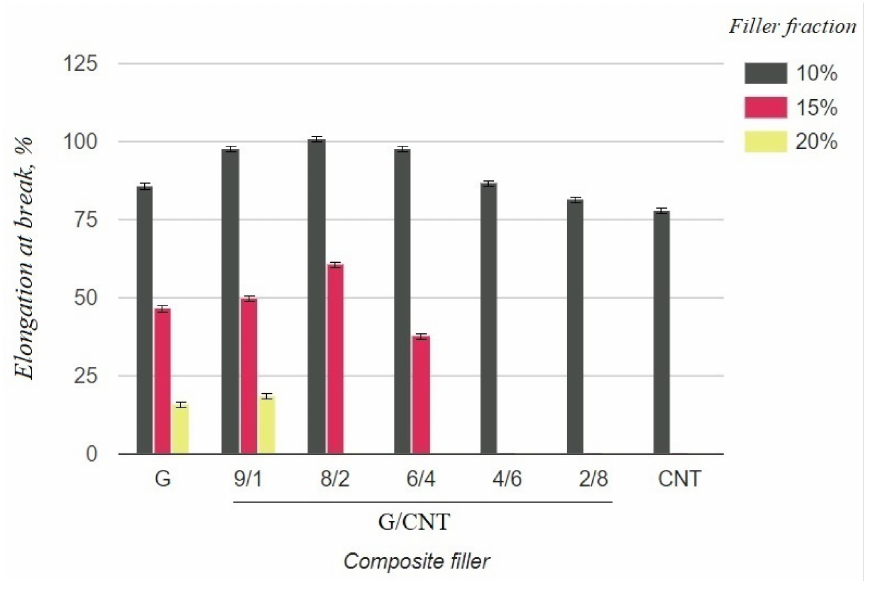
Figure 4. Elongation at break of silicone composites with different filler